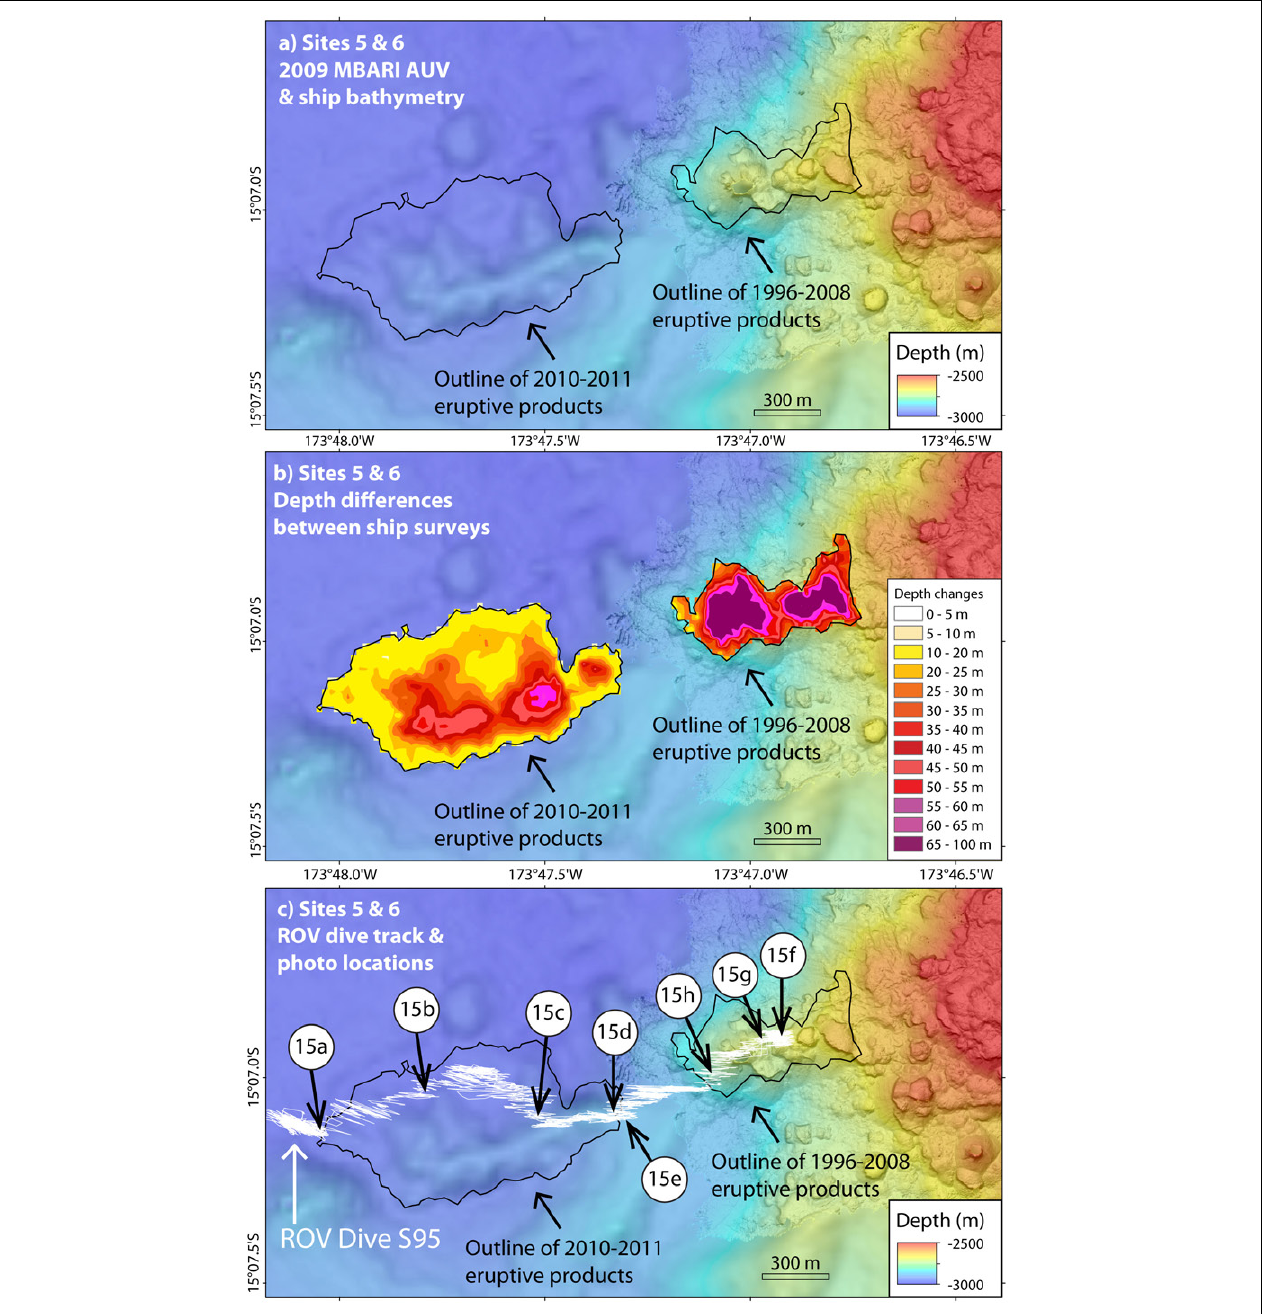
FIGURE 14 | Map of eruption sites #5 (left) and #6 (right), at the SW base of West Mata (see Figure 2 ) showing (a) post-site-#5-eruption ship-based bathymetry (left) overlain with post-site-#6-eruption MBARI AUV bathymetry from 2009 (right), (b) positive depth differences between ship-based surveys (2010–2011 at left, 1996–2008 at right, see Table 2 ), and (c) trackline of SuBastian ROV dive S95 (white line) on post-eruption bathymetry, with locations of images in Figure 15 (white numbered circles). Note that the navigation for this dive was considerably noisier than for others on this expedition due to problems with the acoustic tracking system on R/V Falkor . Black outlines enclose the site #5 and #6 eruption